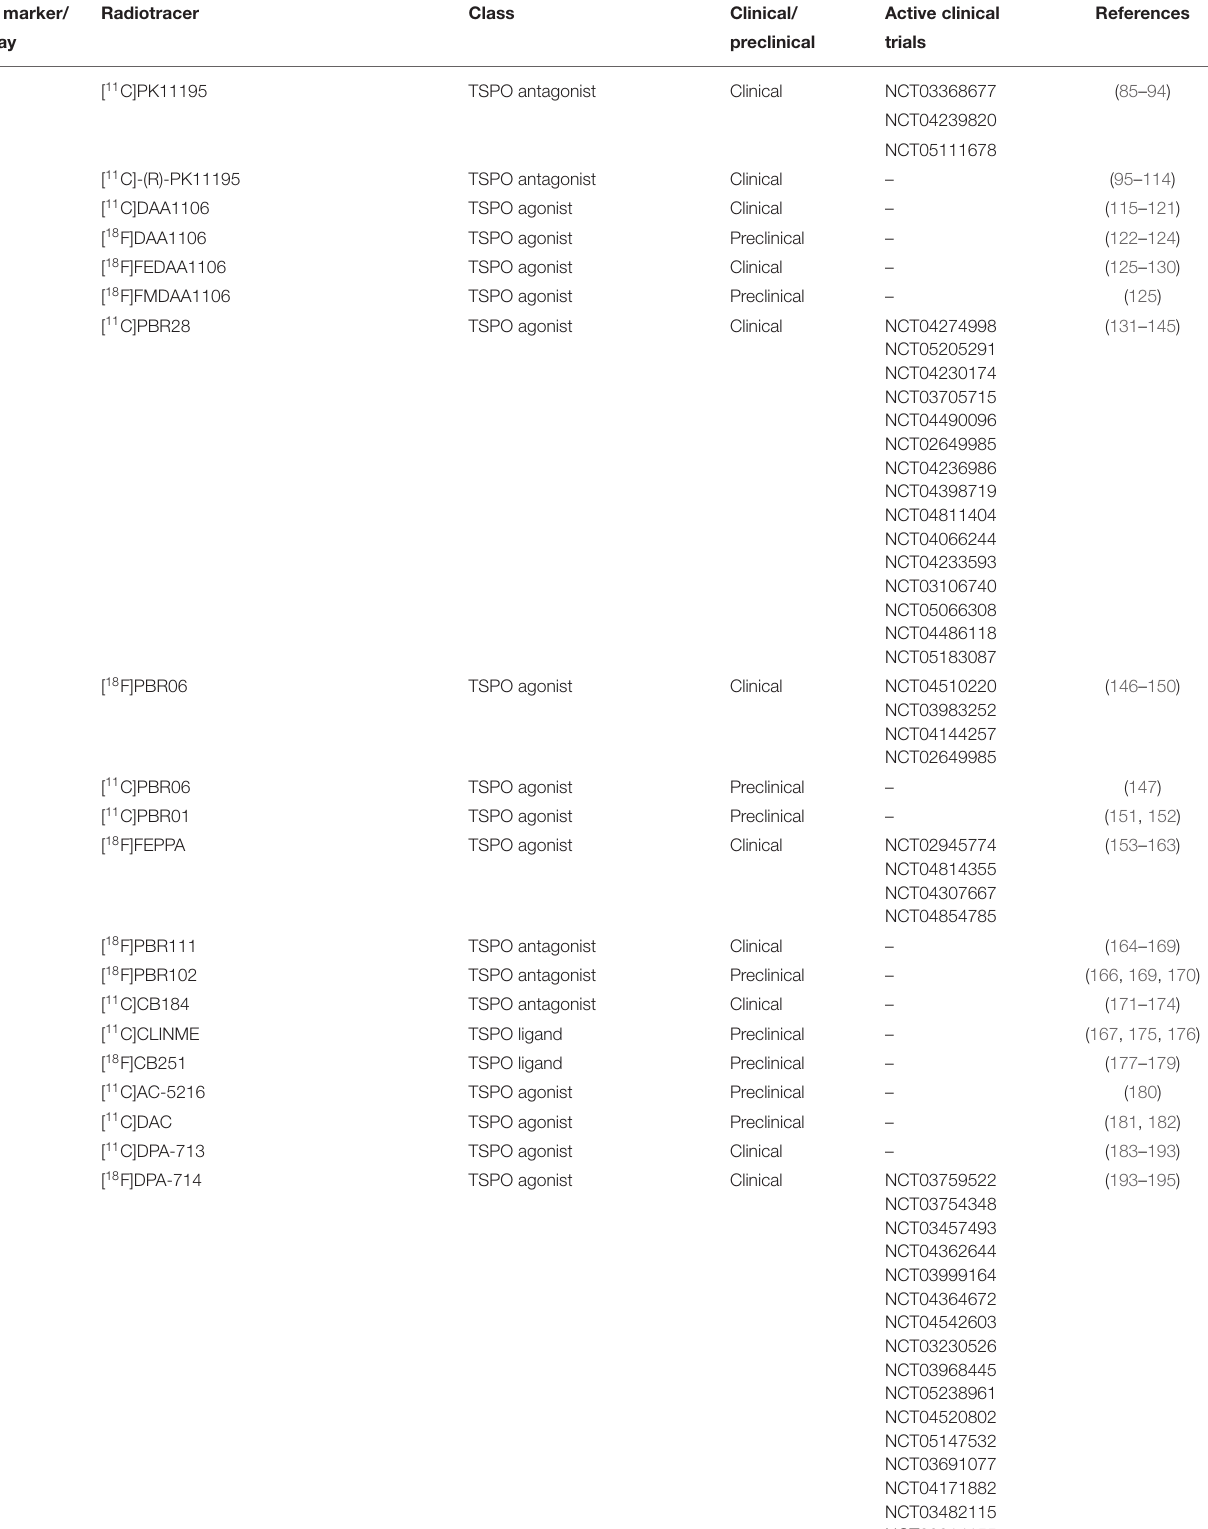
TABLE 2 | Macrophage targeted PET